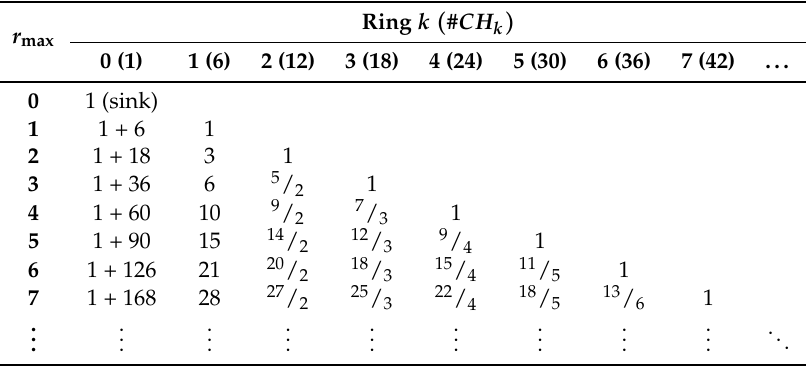
Table 5. Coefficients c k according to Equation